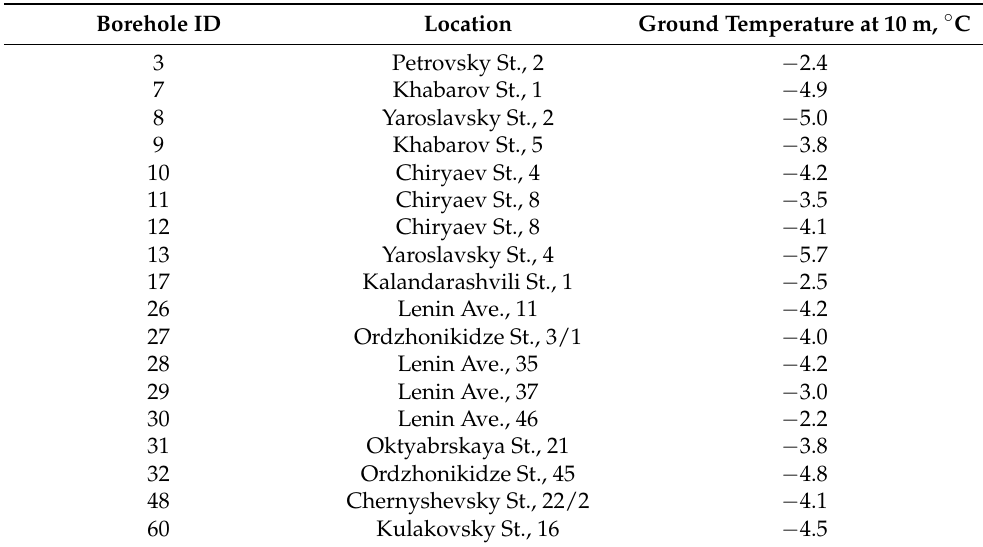
Table 5. Permafrost temperatures at thermal monitoring network sites within the older part of Yakutsk,